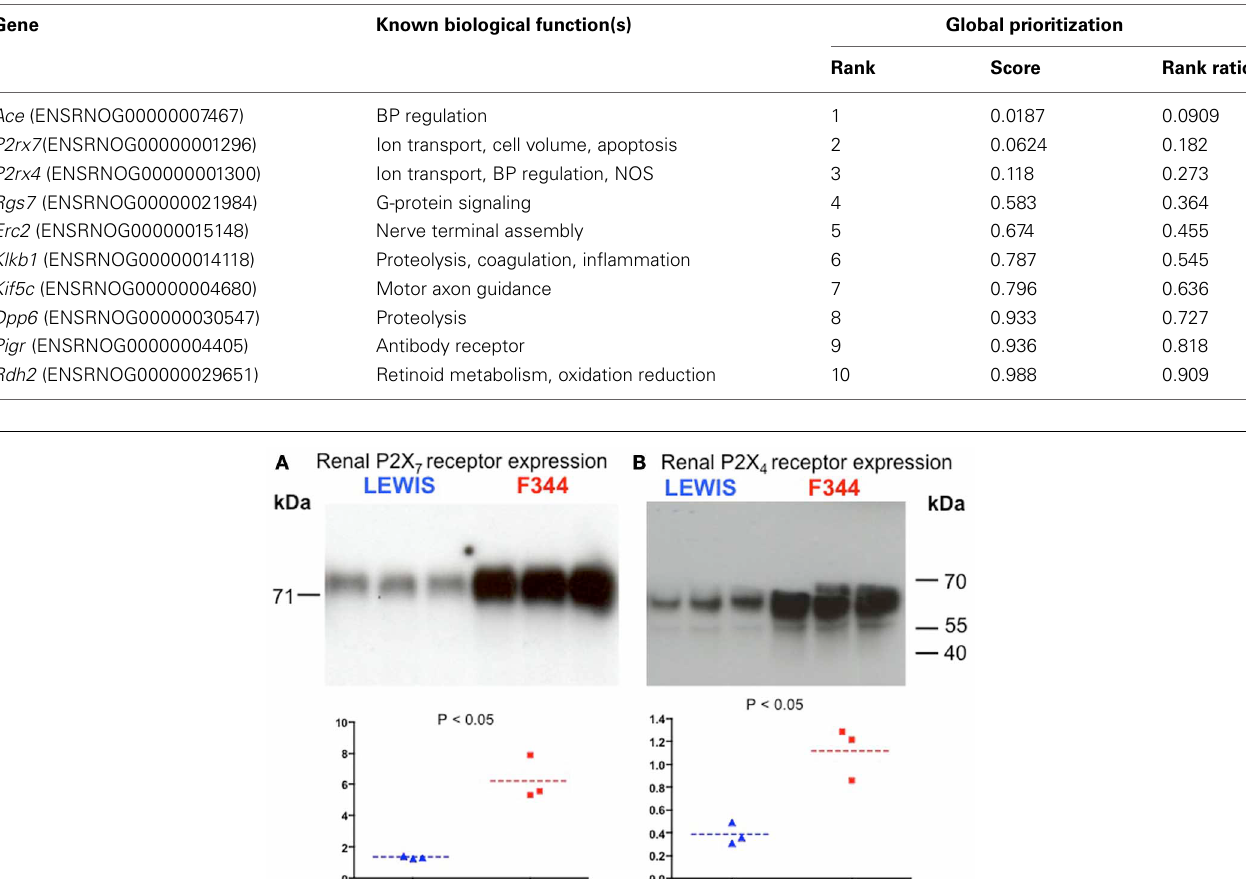
P2X 7 receptors have also been immunolocalized to the